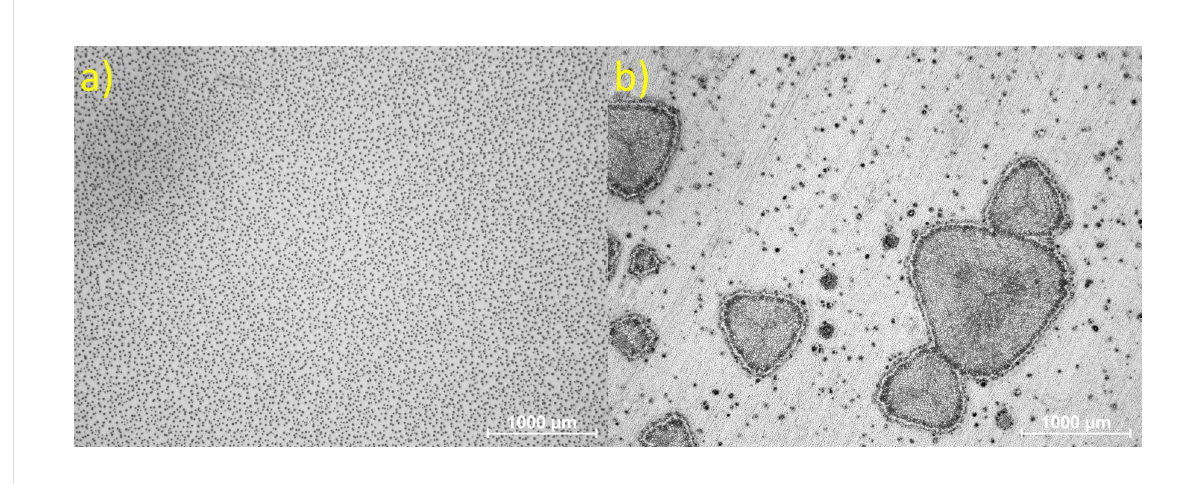
Figure 6: Microscope images at 2.5× magnification of SU-8 nanocomposites after post-exposure bake at 95 °C; a) with 250 mg·mL − 1 of AgNO 3 precursor solution added and b) 500 mg·mL − 1 of AgNO 3 precursor solution added.